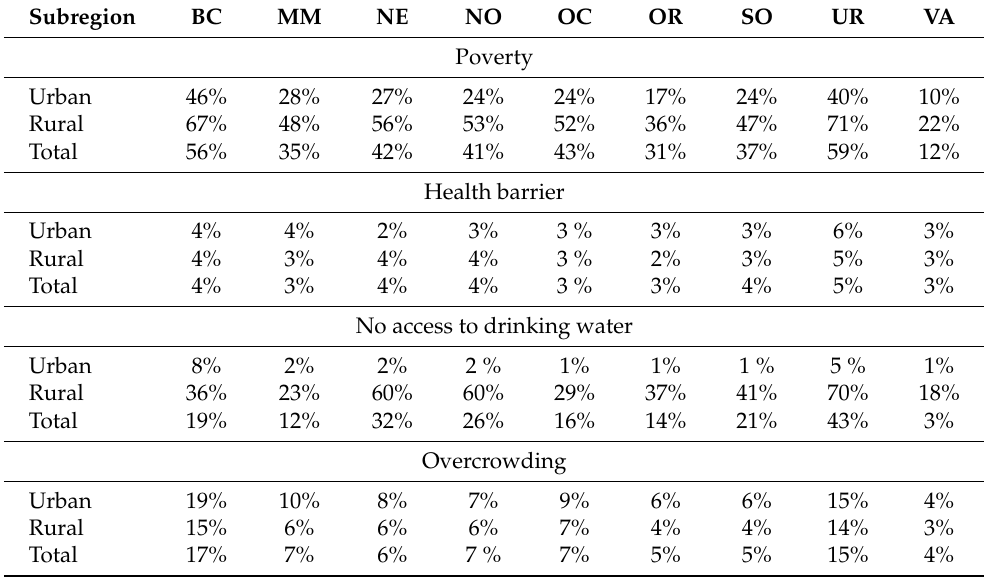
Table 10. Distribution of the population corresponding to the demographic groups in each subregion: 46% and 64% of the urban and rural population in CB are in poverty, respectively. However, because each settlement has a different population size, the percentage of the total does not sum to 100%. Source: Departamento Administrativo Nacional de Estadística (DANE, Spanish acronym), www.dane.gov.co (accessed on 31 January